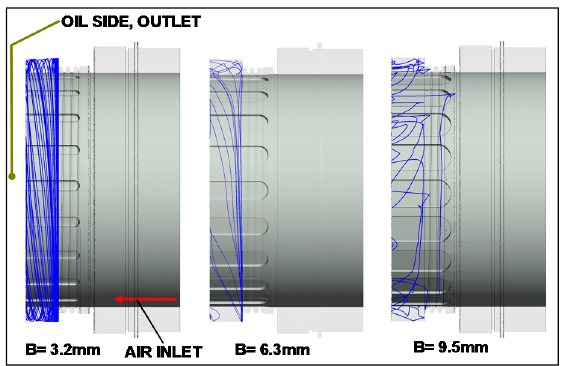
Figure 19. Oil trajectories at 15,000 rpm and different widths B of the scallops.